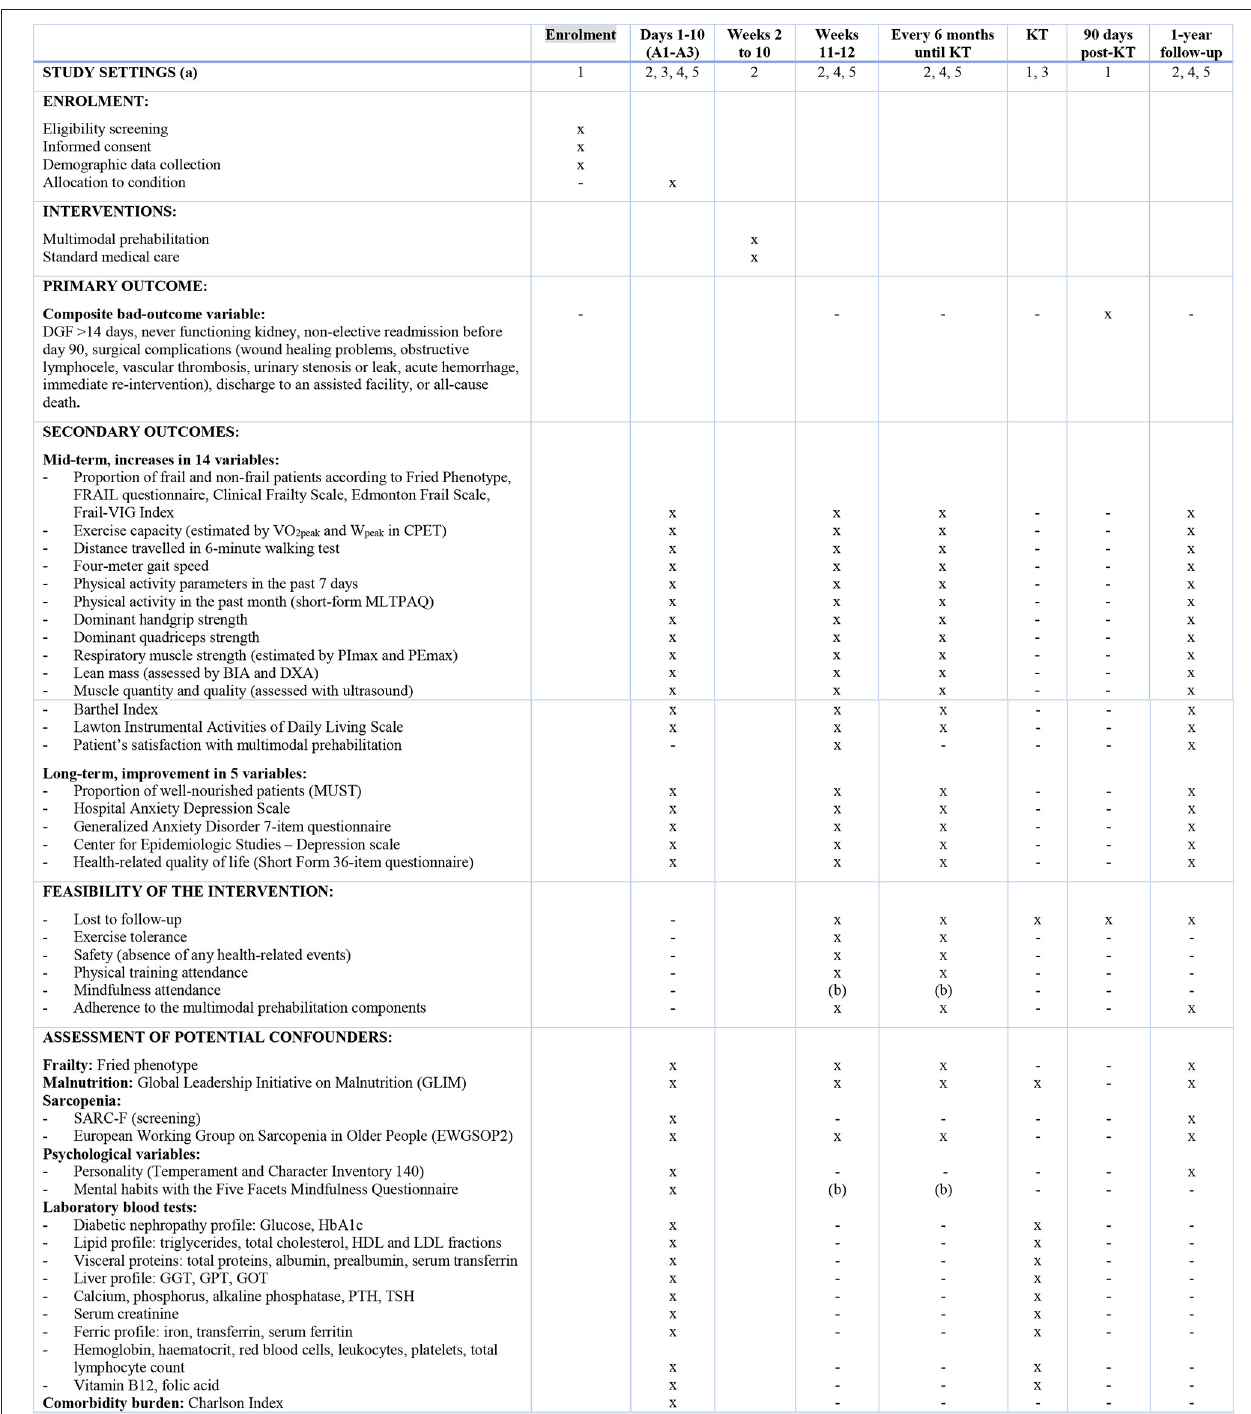
FIGURE 1 | Study settings and schedule of enrolment, interventions, and assessments. (a) Settings: (1) Nephrology Department; (2) Physical Medicine & Rehabilitation Department; (3) Internal Medicine Department; (4) Endocrinology Department; (5) Psychiatric Department. (b) Time of assessment will depend on starting date of the Mindfulness sessions. KT, kidney transplantation; VO2, oxygen uptake; W, workload; CPET, cardiopulmonary effort test; MLTPAQ, Minnesota Leisure-Time Physical Activity Questionnaire; BIA, bioelectrical impedance analysis; DXA, Dual X-ray Absorptiometry; PImax, maximal inspiratory pressure; PEmax, maximal expiratory pressure; SARC-F, Strength, Ambulation, Resistance, Climbing, Falls.